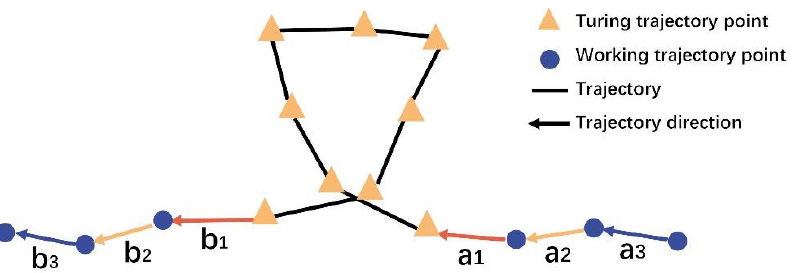
Figure 4. Schematic diagram of the turning trajectory correction method based on direction change. 𝑎 1 , 𝑎 2 , 𝑎 3 are the first second and third vectors before the target trajectory respectively; 𝑏 1 , 𝑏 2 , 𝑏 3 are the first second and third vectors after the target trajectory respectively.